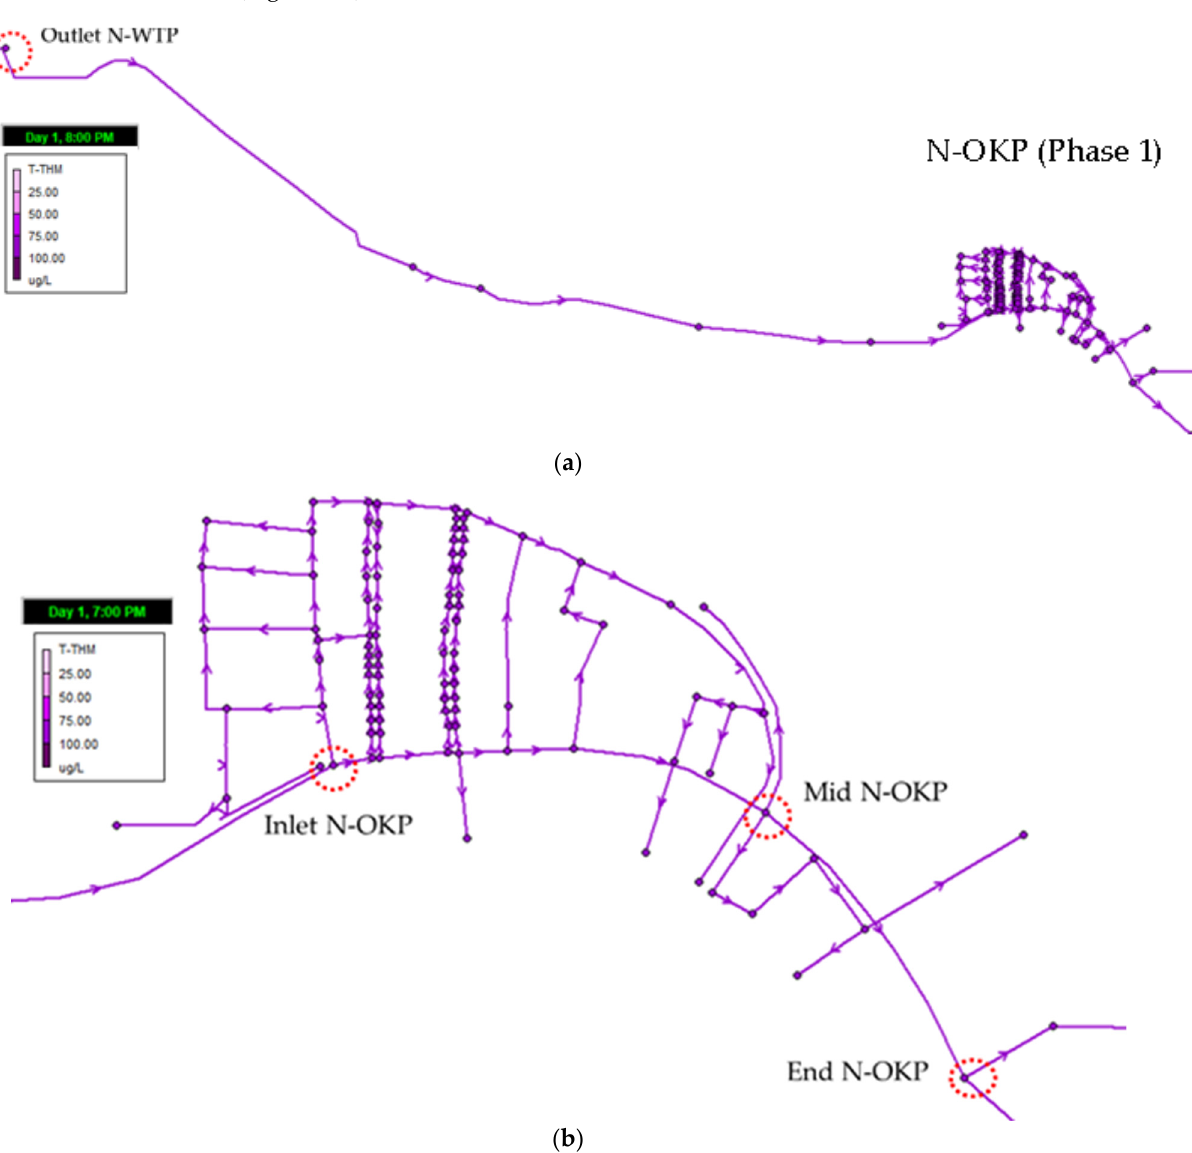
Figure 13. Simulation of chlorine in Phase 1 (initial chlorine 0.8 mg/L): ( a ) Phase 1 model, ( b ) chlorine in N-OKP area, ( c ) chlorine concentration in model.